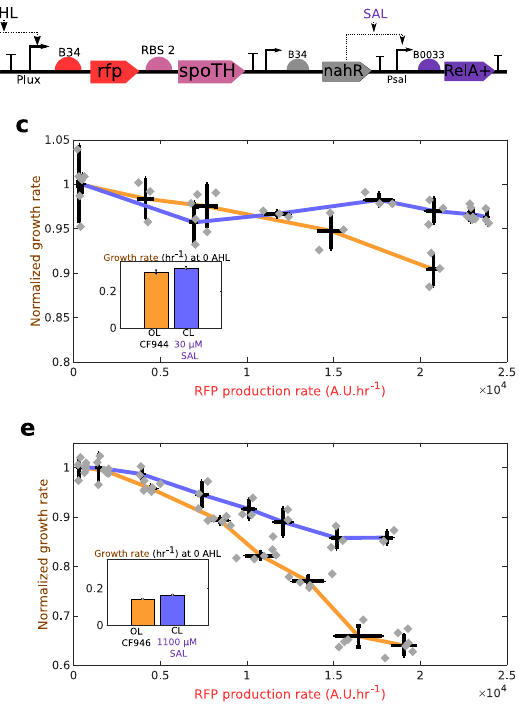
Fig. 5 | Feedforward ribosome controller compensates for burden caused by activationofthe RFP gene ina common laboratory strain and across different nominal growth rates. a CL system ’ s genetic construct (P_IFFL_RelA_2) co- expresses RFP and SpoTH via the AHL inducible Plux promoter. The SpoTH RBS is fi xed to RBS 2 (Supplementary note 5). RelA+ is expressed using the SAL inducible Psalpromoter. b Circuitdiagram depictingthe effectof activatingRFP(AHLinput) on ribosomes and growth rate for the open loop (OL) or closed loop (CL) systems. IntheOLsystem,SpoTHisnotpresent,sothereisonlytheupperpathfromAHLto growth rate. In the CL system, AHL also activates SpoTH production and hence upregulates ribosome concentration and growth rate. Dashed edges represent sequestration of freeribosomesby aprotein ’ s expression.RelA+ activation via SAL sets the basal level of ppGpp and thus the nominal growth rate 64 . c – e Growth rate